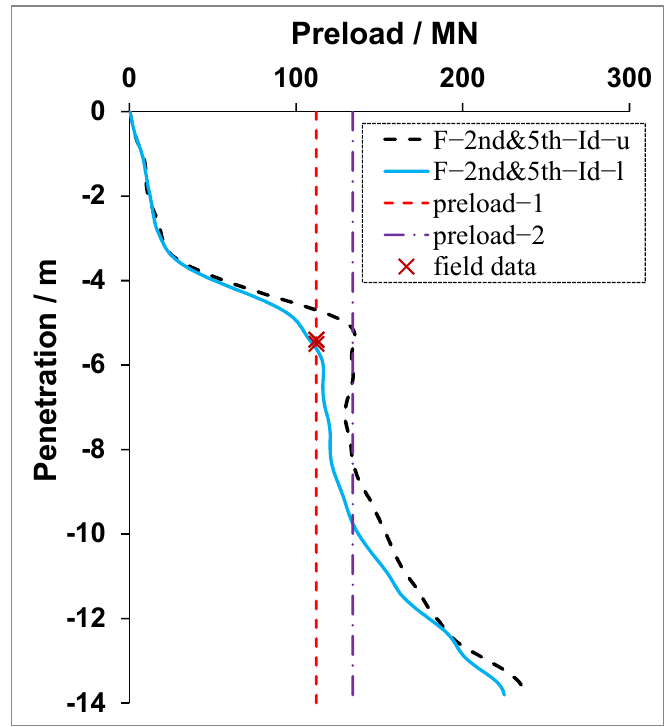
Figure 6. Comparison of penetration resistance profiles of spudcan at a field site.